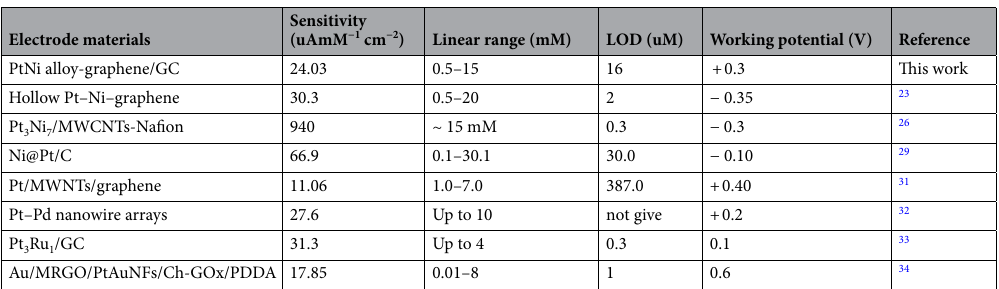
Table 1. Comparison of different non-enzymatic Pt and Pt-base glucose sensors.